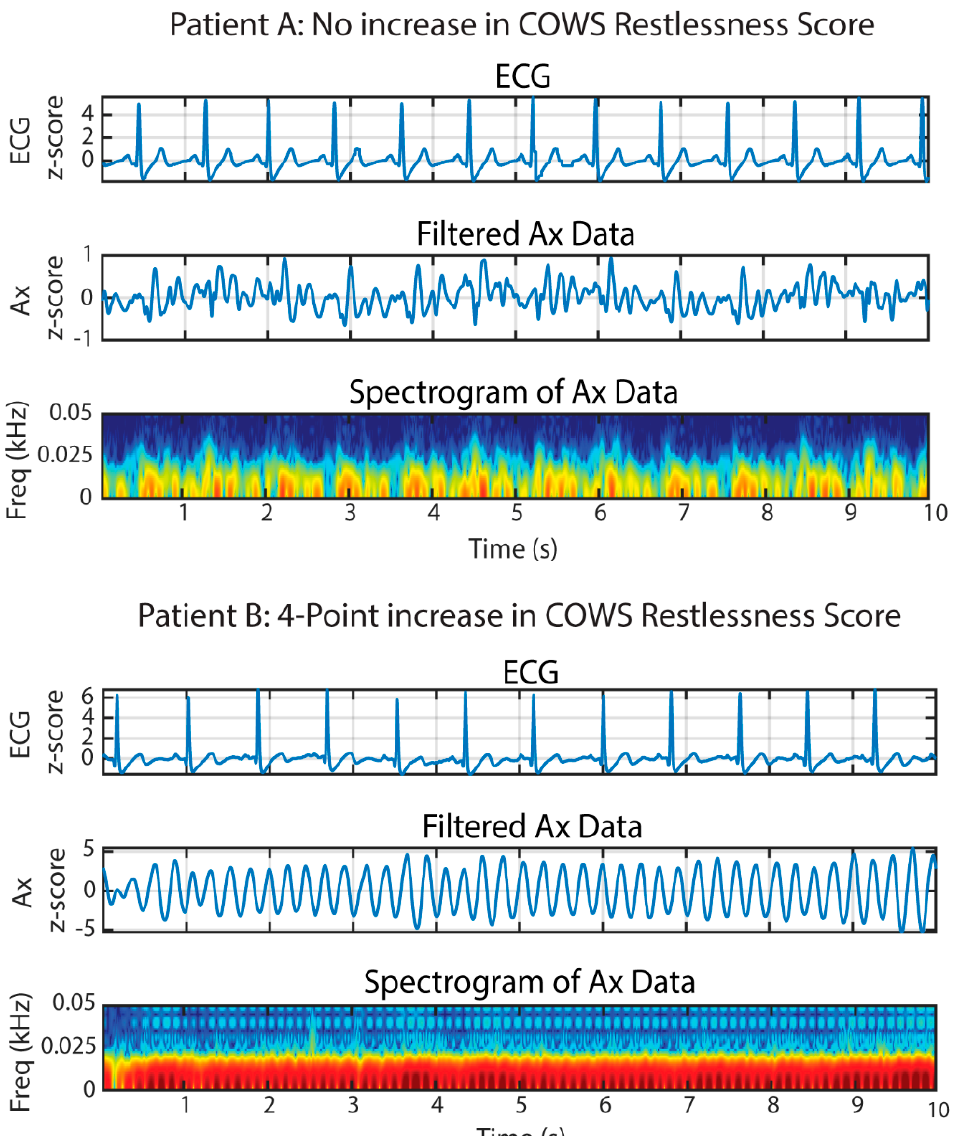
Figure 2. Spectral analysis of accelerometer waveforms extracted from 10 − s windows during the experiment. Patient A represents patients not exhibiting sinusoidal wave patterns and having no increase in their COWS restlessness scores, while Patient B represents patients exhibiting sinusoidal wave patterns and having a four-point increase in their COWS scores. The amplitudes of the electrocardiogram (ECG) and accelerometer signals in the Ax-direction were normalized using z-score normalization as indicated by the y-axes in the figure. All accelerometer waveforms are taken from the craniocaudal direction. The dark red color where the highest energy content is located (and where LBFT is located) is between 0 − 10 Hz. The other colors such as yellow and blue are low energy noise signals.